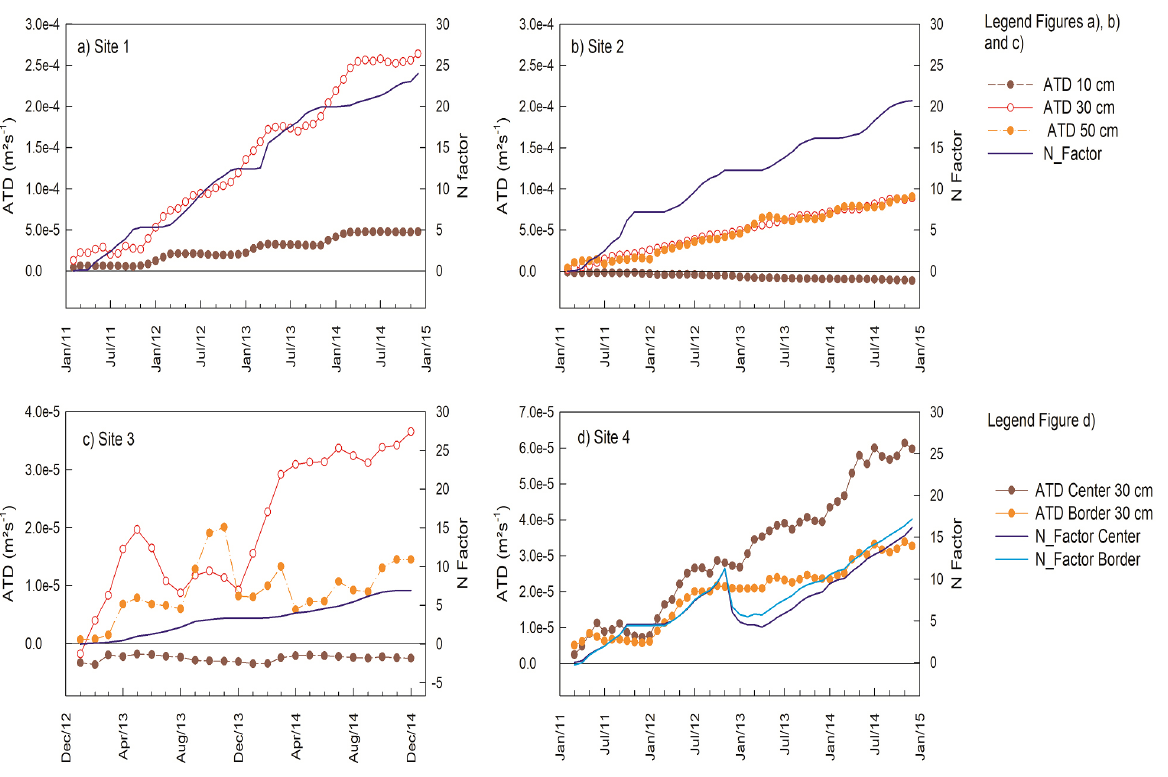
Figure 3. Relationship between the accumulated N-factor and ATD in Keller Peninsula, Maritime Antarctica. *ATD 10 = apparent thermal diffusivity at 5, 10 and 30 cm depth and ATD30 = apparent thermal diffusivity at 10, 30 and 100 cm depth (site 1); ATD 10 = apparent thermal diffusivity at 5, 10 and 30 cm depth 5, 10 and 30 cm depth; ATD 30 = apparent thermal diffusivity at 10, 30 and 50 cm depth and ATD 50 = apparent thermal diffusivity at 30, 50 and 100 cm depth (sites 2 and 3). ATD = apparent thermal diffusivity at 10, 30 and 80 cm depth at the polygon border (TB) and TC/TB_30 center (TC). U = Soil moisture at 10, 30, 50, 80 and 100 cm depth. UC = Soil moisture at polygon center; UB = Soil moisture at polygon